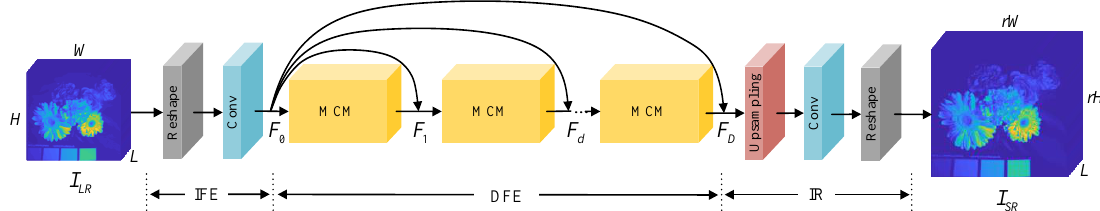
Figure 3. Overall architecture of our proposed MCNet. The whole network mainly contains three parts. First, the low-resolution hyperspectral image I LR is fed into initial feature extraction (IFE) sub-network. Then, these shallow features go through several mixed convolution modules (MCMs) and skip connections to obtain the depth features of the hyperspectral image in deep feature extraction (DFE) sub-network. Finally, these feature maps are upsampled according to scale factor r in image reconstruction (IR) sub-network. The reconstructed hyperspectral image I SR is obtained by convolution and reshape.